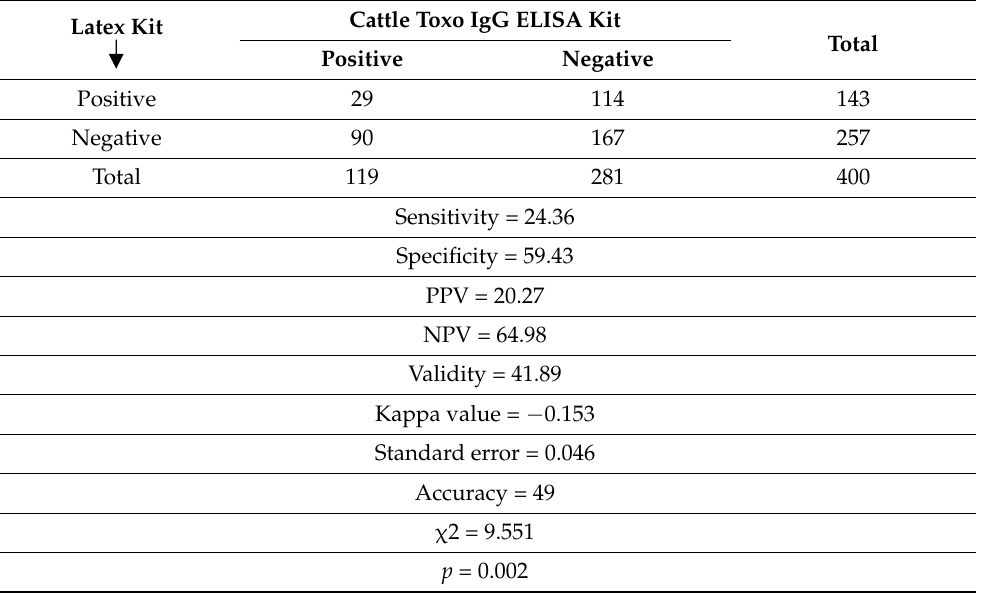
Table 3. Performance of LAT relative to Cattle Toxo IgG ELISA kit for detection of anti- T. gondii IgG ( n = 400).